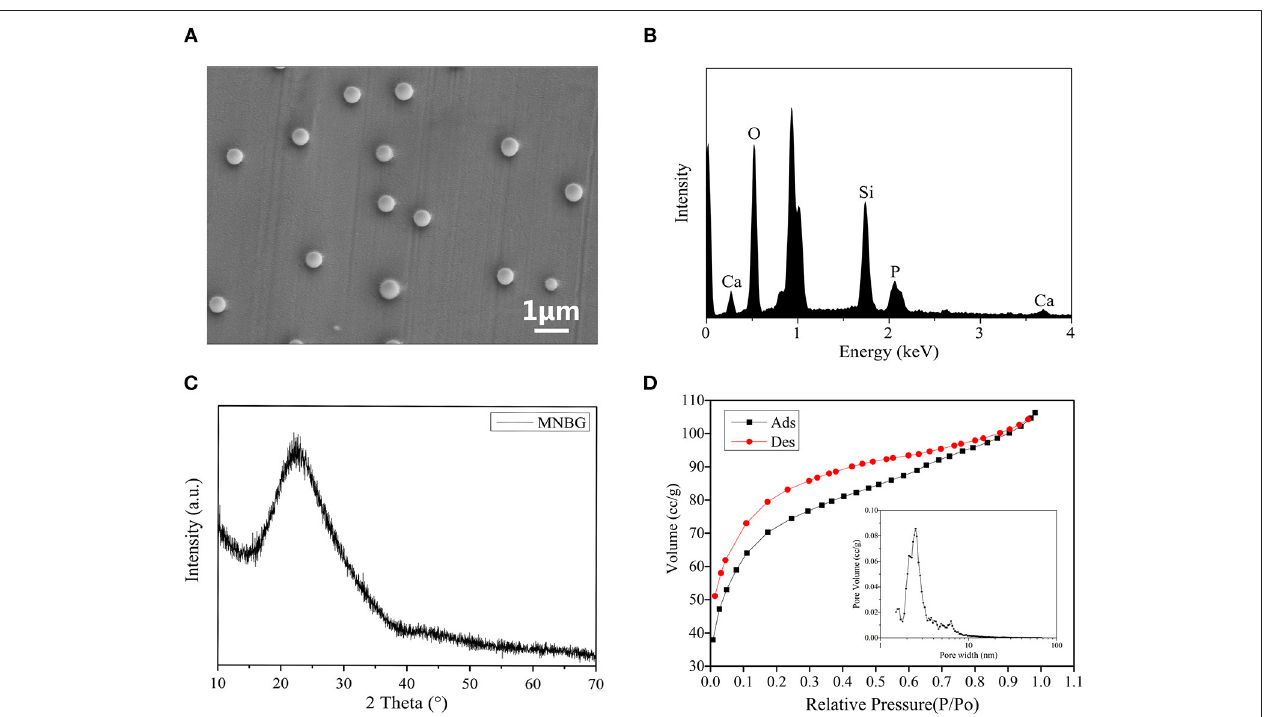
FIGURE 1 | Characterizations of MNBG. (A) SEM image indicating the morphology of MNBG with uniform monodisperse sphere. (B) EDS spectra showing the existence of Si, Ca and P. (C) XRD pattern demonstrating the representative amorphous state of MNBG. (D) The N 2 adsorption-desorption isotherms and pore size distributions of MNBG.